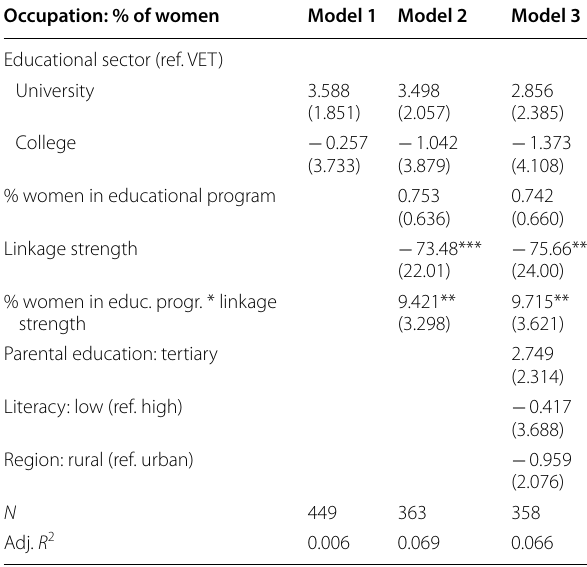
Table 9 Influence of educational gender concentration and linkage strength on occupational